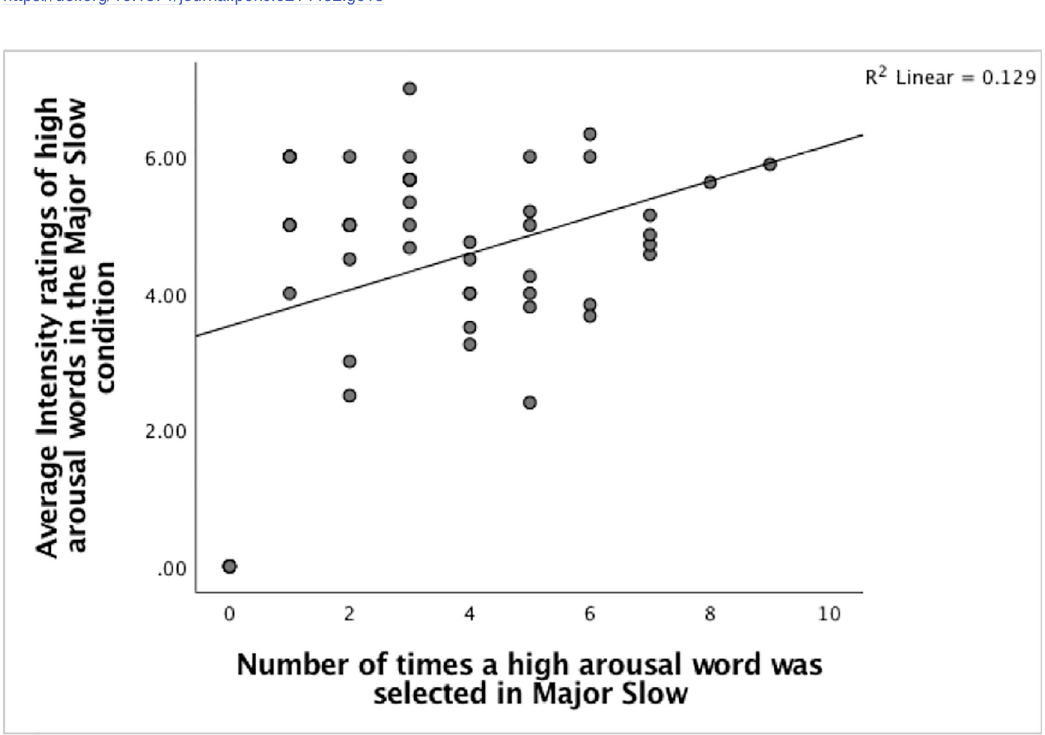
Fig 14. The relationship between the number of high arousal words selected and the rated intensities in the Major-Slow condition.